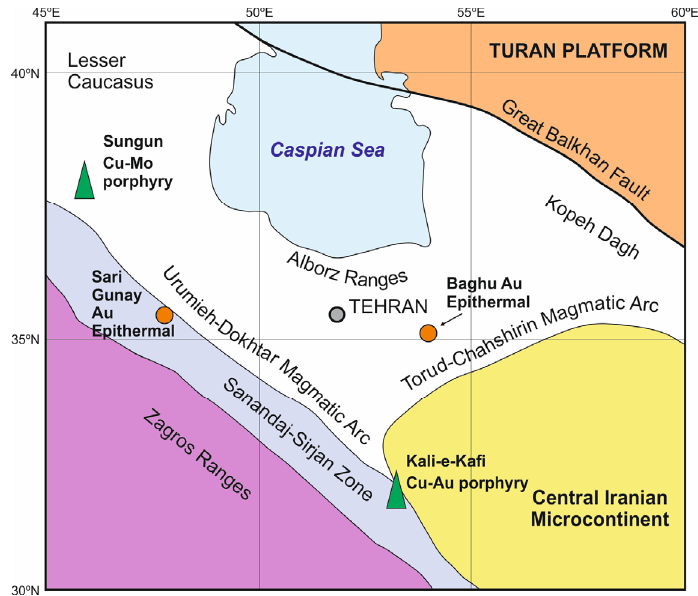
Figure 21. Distribution of major adakite-hosted Cu (Au, Mo) porphyry (triangles) and Au epithermal (circles) deposits in Iran (Western Tethyan Belt). Crustal terranes (Zagros Ranges, Sanandaj-Sirjan Zone, Alborz Ranges), cratonic cores (Turan Platform and Central Iranian Microcontinent) and magmatic arcs (Lesser Caucasus, Kopeh Dagh, Urumieh-Dokhtar and Torud-Chahshirin) are after [283,284,287,288].